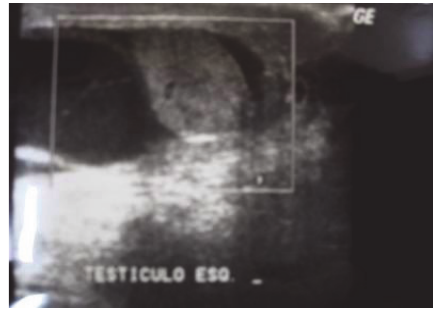
Figure 2: US showing a cystic mass and normal left testis.